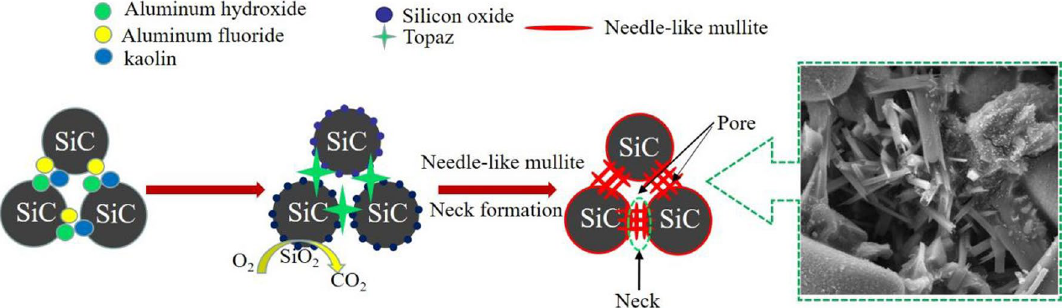
Fig. 5 A schematic showing the sintering process of needle-like mullite-bonded SiC